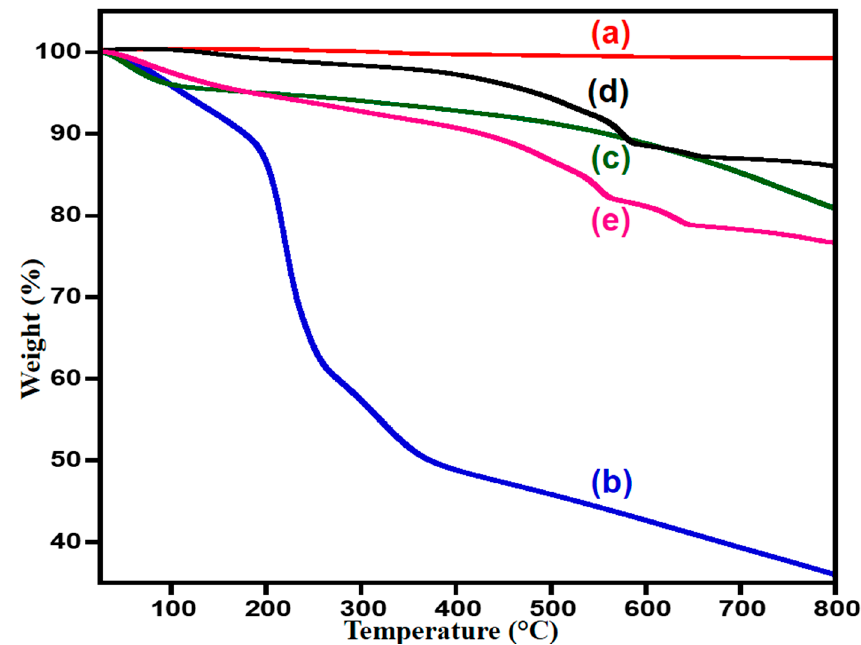
Figure 2. TGA curves of ( a ) graphite; ( b ) GO; ( c ) HRG; ( d ) ZnO x (1%)–MnCO 3 ; and ( e ) ZnO x (1%)–MnCO 3 /(1%)HRG.